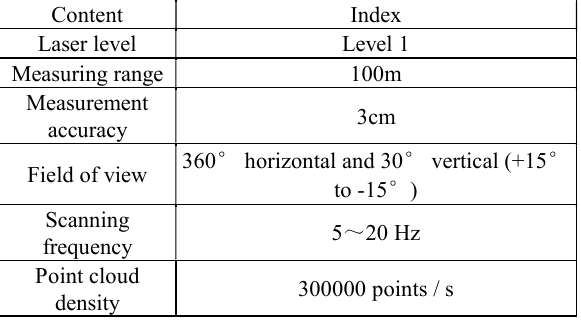
Table 3. Comparison of measured data